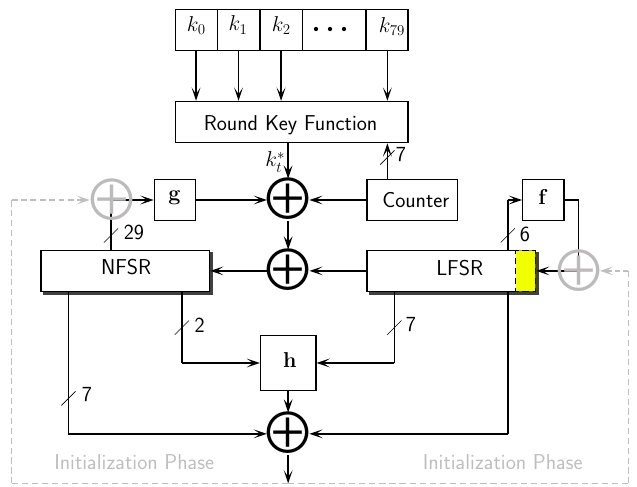
Figure 1: Block Diagram of